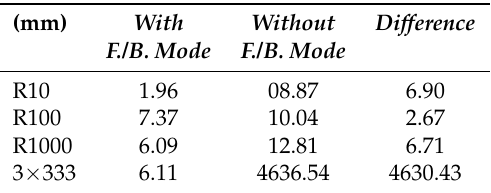
Table 5. Distance to true barycenter with an inversion with or without forward/backward mode for the four simulated trajectories considered, using an inversion mode with baseline lengths and δ z as